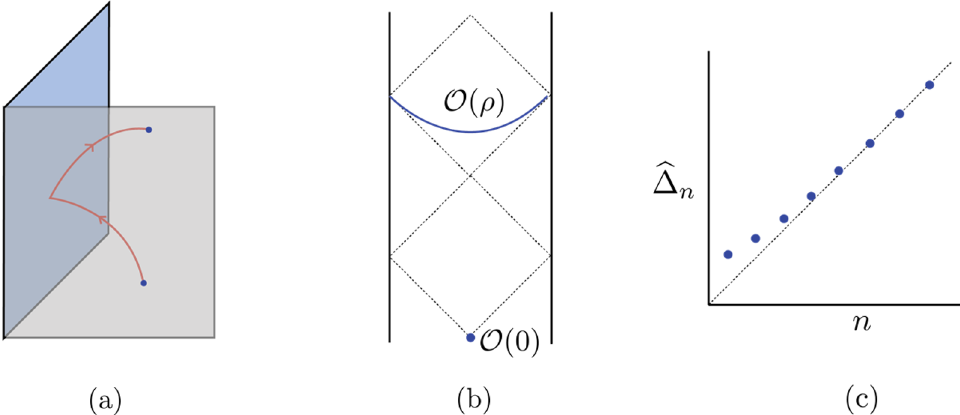
Figure 1. (a) A light ray leaving the boundary and returning to the boundary at a later time (in this example reflecting off an ETW brane); (b) The bulk causal structure then implies new ‘bulk brane’ singularities in the BCFT to the future of a BCFT operator; (c) The bulk brane singularities require a careful alignment of operator dimensions appearing on the boundary of the